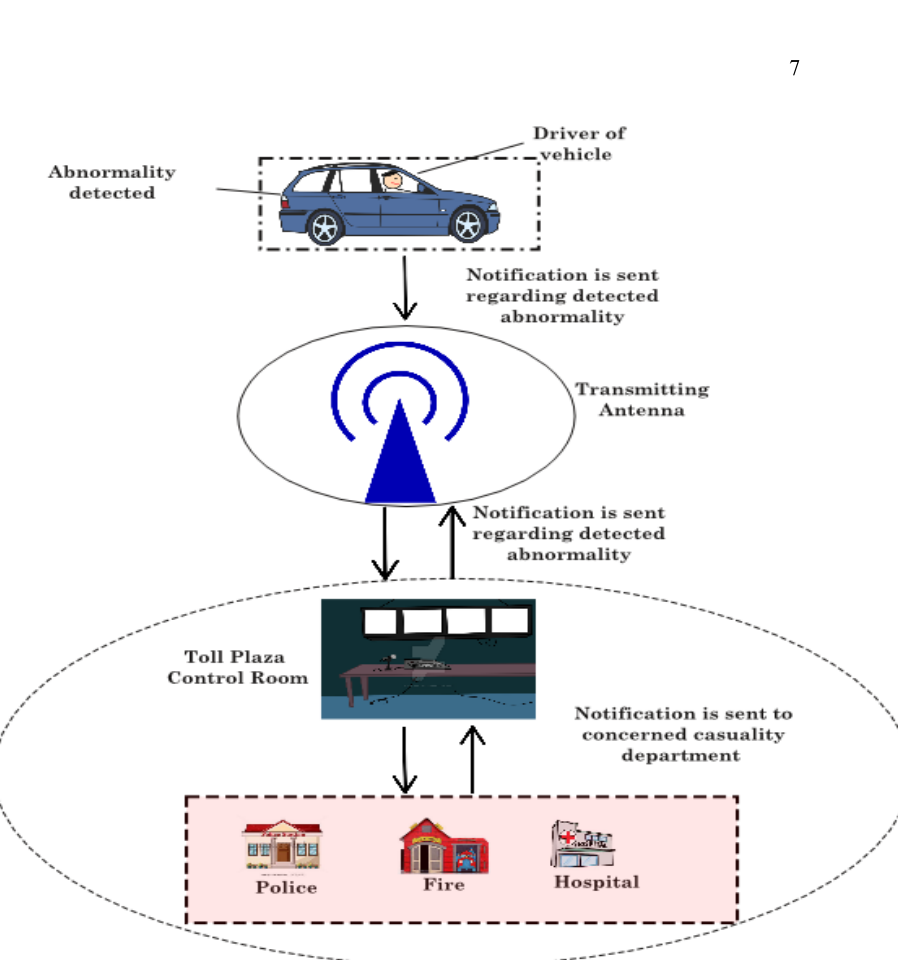
Fig. 5. Basic communication architecture for accident